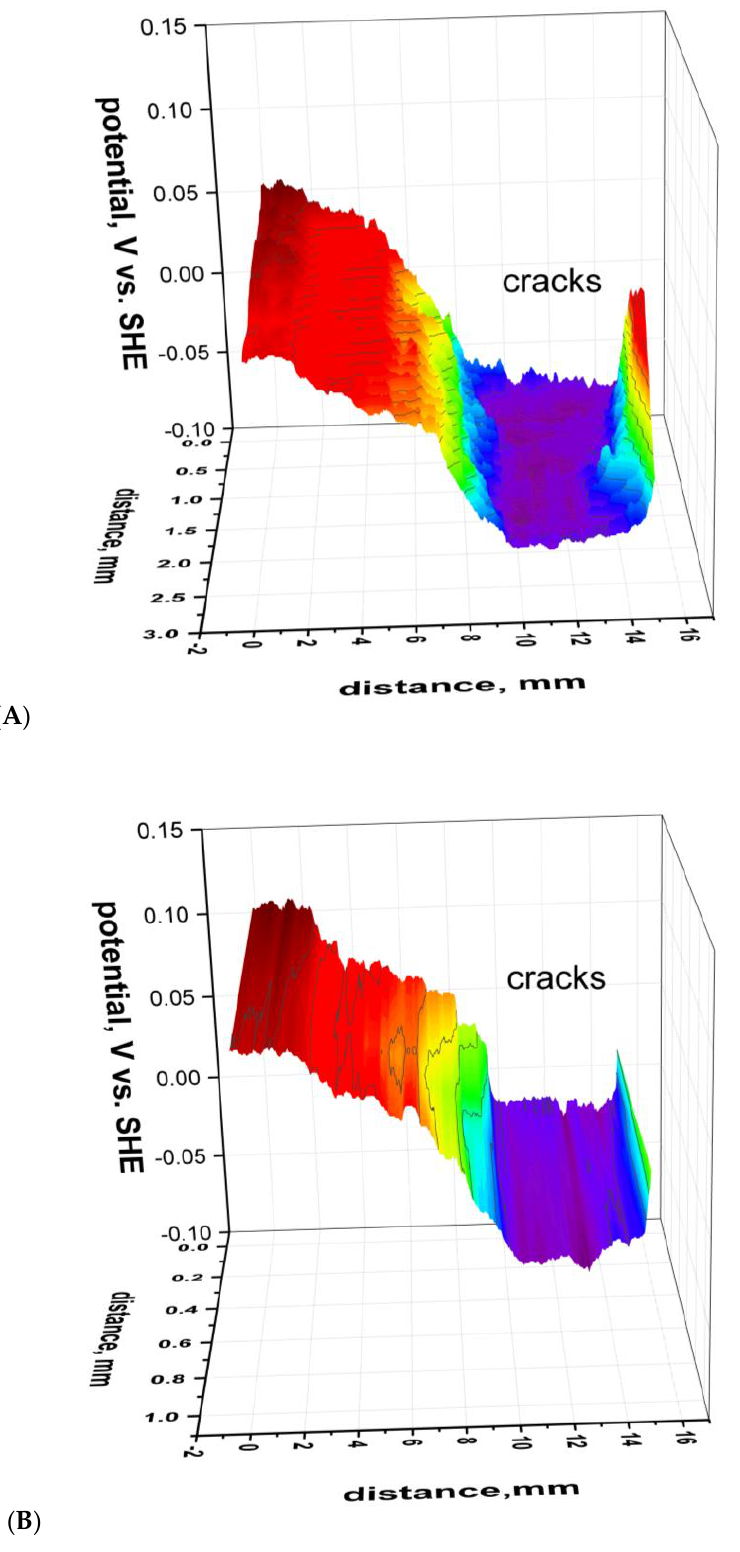
Figure 5. SKP potential distribution for HSS 1500 steel after cathodic polarization with a current density of − 25 mA/cm 2 in 0.3 M Na 2 SO 4 (pH 2) aqueous electrolyte for a duration of 25 h. The measurements were performed in air at 60% RH, after cathodic charging at 4 h ( A ) and 24 h ( B ).